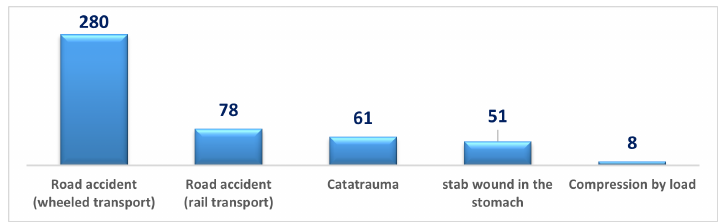
Figure 7. Distribution of patients by type and mechanism of injury